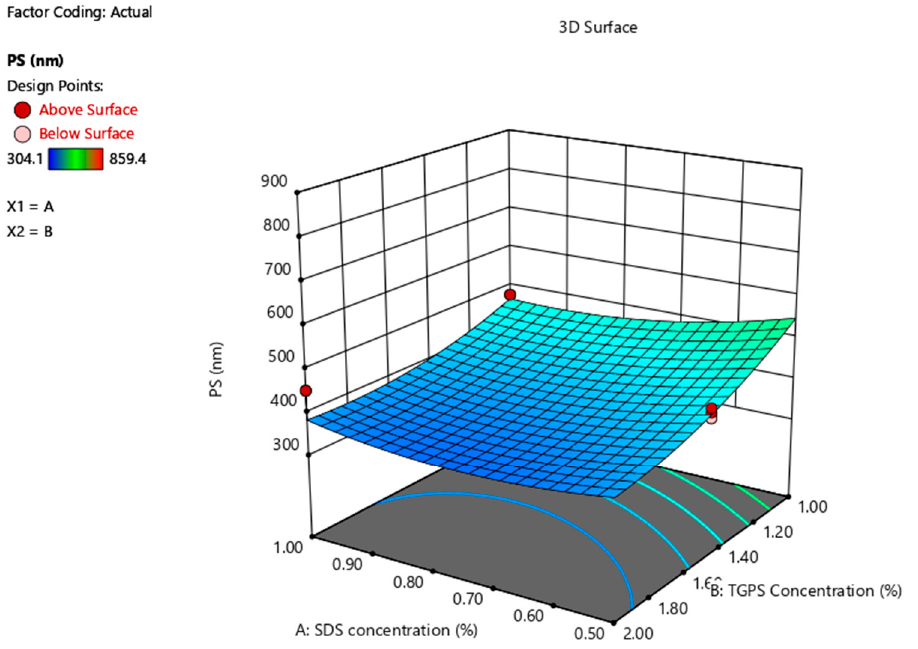
Figure 2. 3D response surface plot depicting the impact of SDS and TPGS 1000 concentration on the PDI of the NCC.